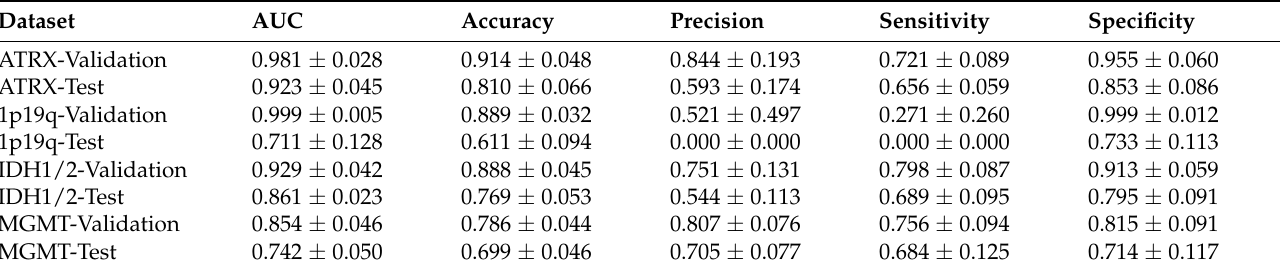
Figure 4. ROC curves of the prediction of the ATRX expression loss ( A ), the 1p19q co ‐ deletion ( B ), the IDH1/IDH2 muta ‐ tion ( C ) and the MGMT ‐ status ( D ) in the validation data set (left) and the test data set (right). Table 6. Performance in predicting the grading. Dataset